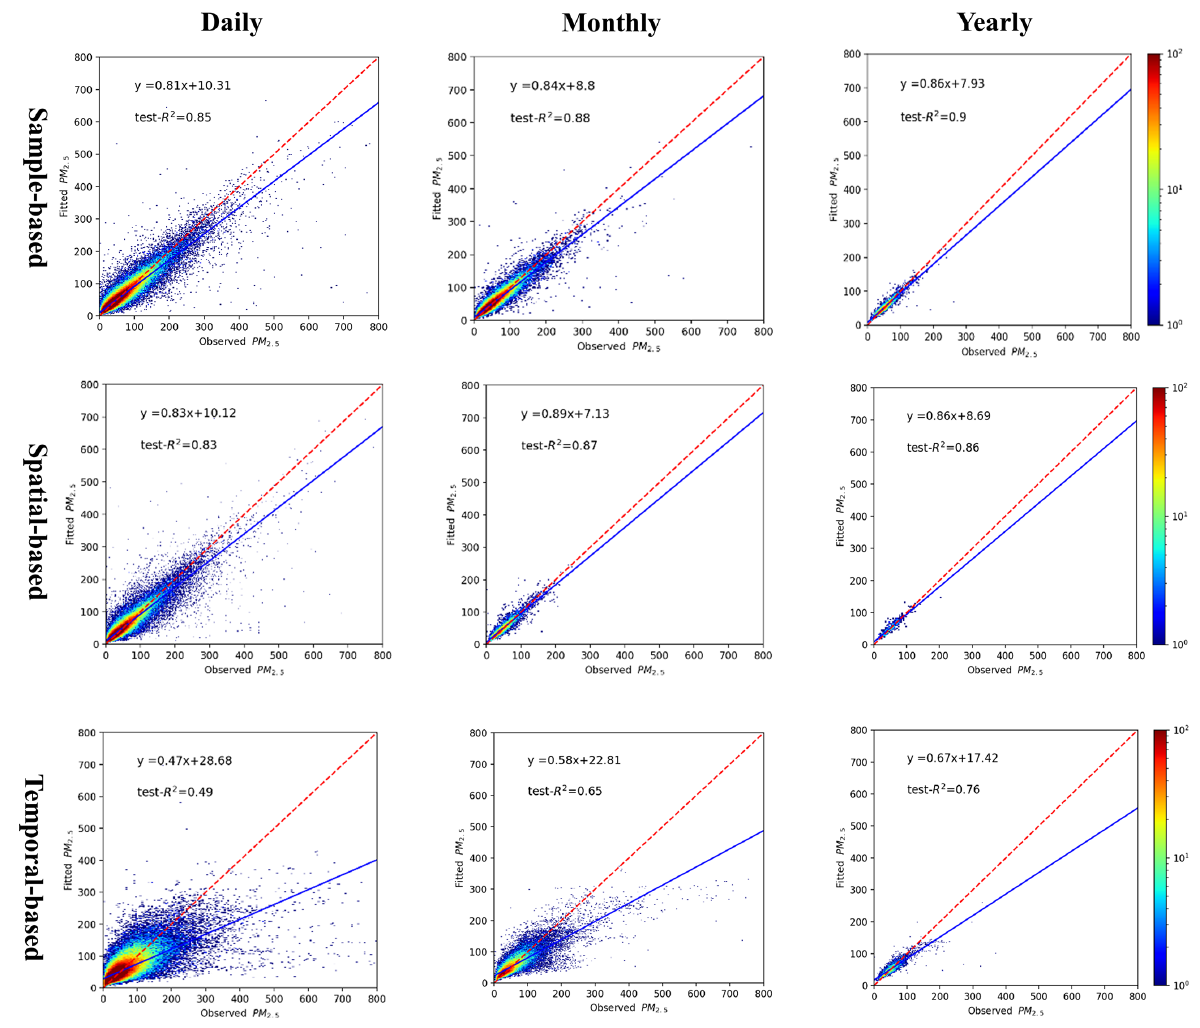
Figure 3. The density plot of PM 2 . 5 model. From left to right are the different temporal scales: daily, monthly and yearly; from top to bottom are the different validation methods: sample-based, spatial-based and